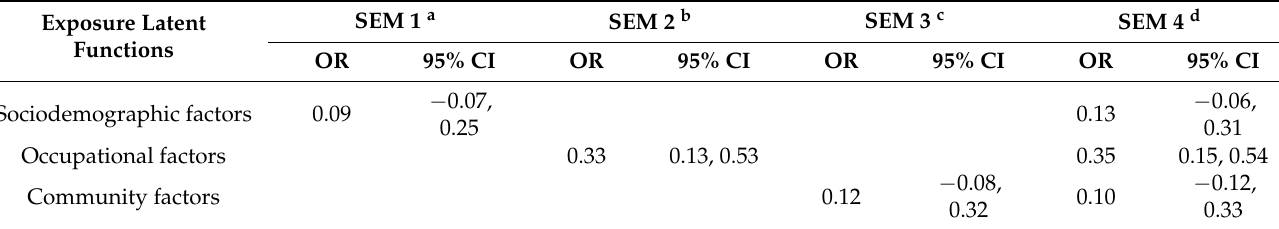
Table 3. Adjusted effect estimates for associations of sociodemographic, occupational and community latent functions with SARS-CoV-2